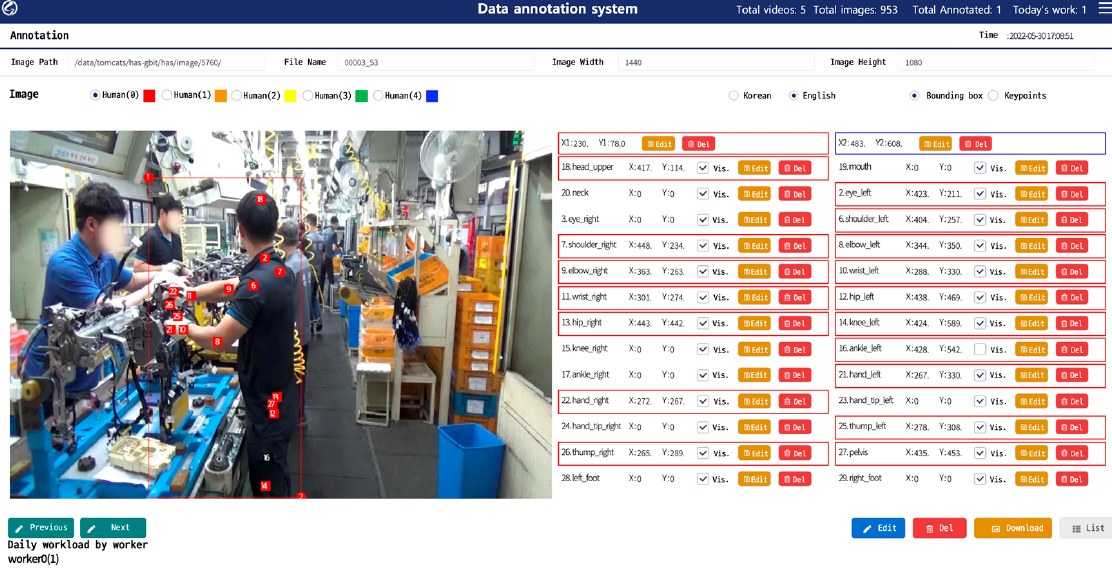
Figure 8. The DyWHSE dataset builder overlays the joint information recorded by